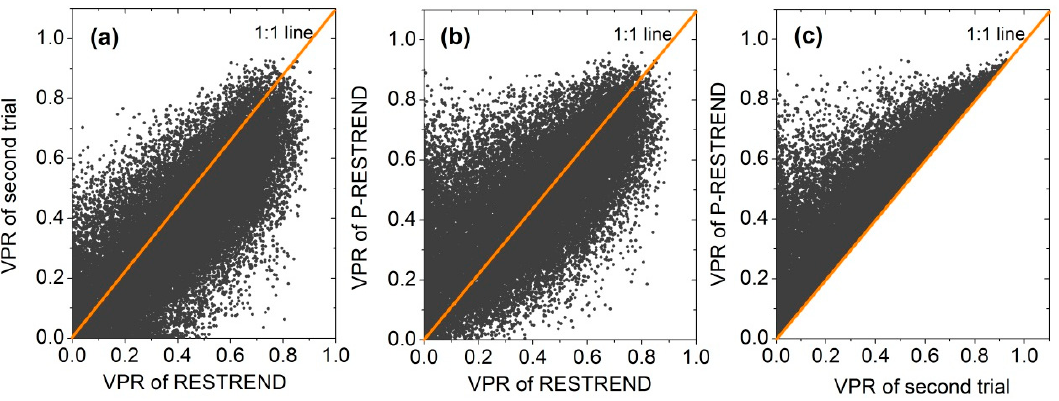
Figure 8. Pixel-by-pixel comparison of R 2 between ( a ) RESTREND and the second method, ( b ) RESTREND and P-RESTREND, and ( c ) the second method and P-RESTREND.